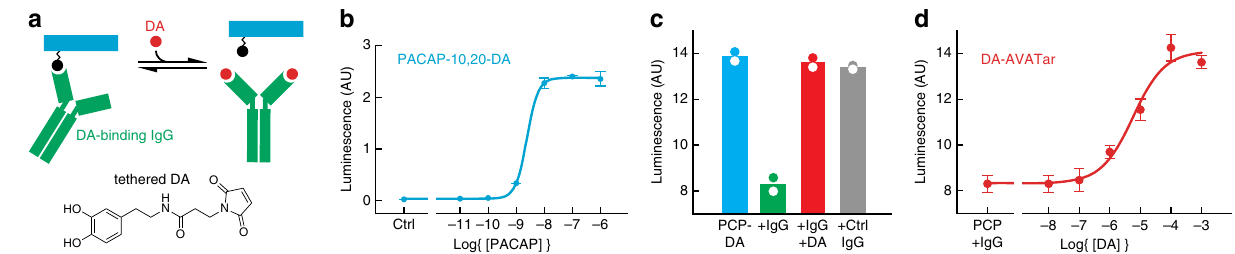
Fig. 5 A neurotransmitter-sensitive AVATar. a Mechanism of dopamine-sensitive AVATars: PACAP (blue) is modi fi ed with a tethered dopamine (DA) analog (black), and a DA-binding IgG (green) functions as the blocking domain. Free neurotransmitter (red) competes with this interaction, releasing active PACAP. Structure of thiol-reactive tethered DA shown at bottom. b Titration of PACAP-10,20-DA in the PAC1 cell assay, showing ef fi cient receptor activation. c PAC1 receptor activation by 1 nM PACAP-10,20-DA in the absence (blue) or presence (green) of 600 nM DA-binding IgG. Activity is restored by addition of excess DA (red). Control IgG (gray) does not block PACAP activity. d Titration of the DA response of 1 nM DA-AVATar in the